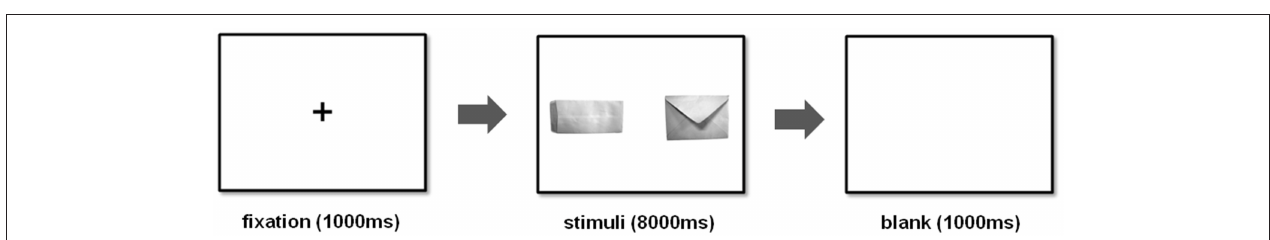
FIGURE 1 | An example of the computer screen as it appeared to the subjects during the task.